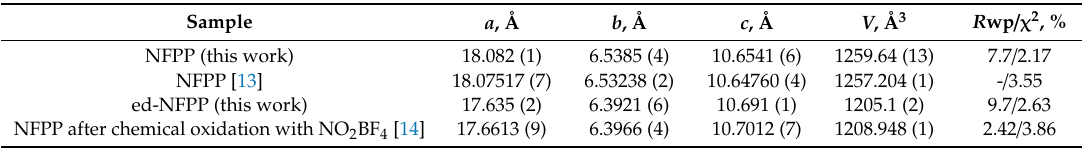
Table 1. Lattice parameters of the pristine sample (NFPP) and the electrochemically de-sodiated sample (ed-NFPP) compared to the literature data.